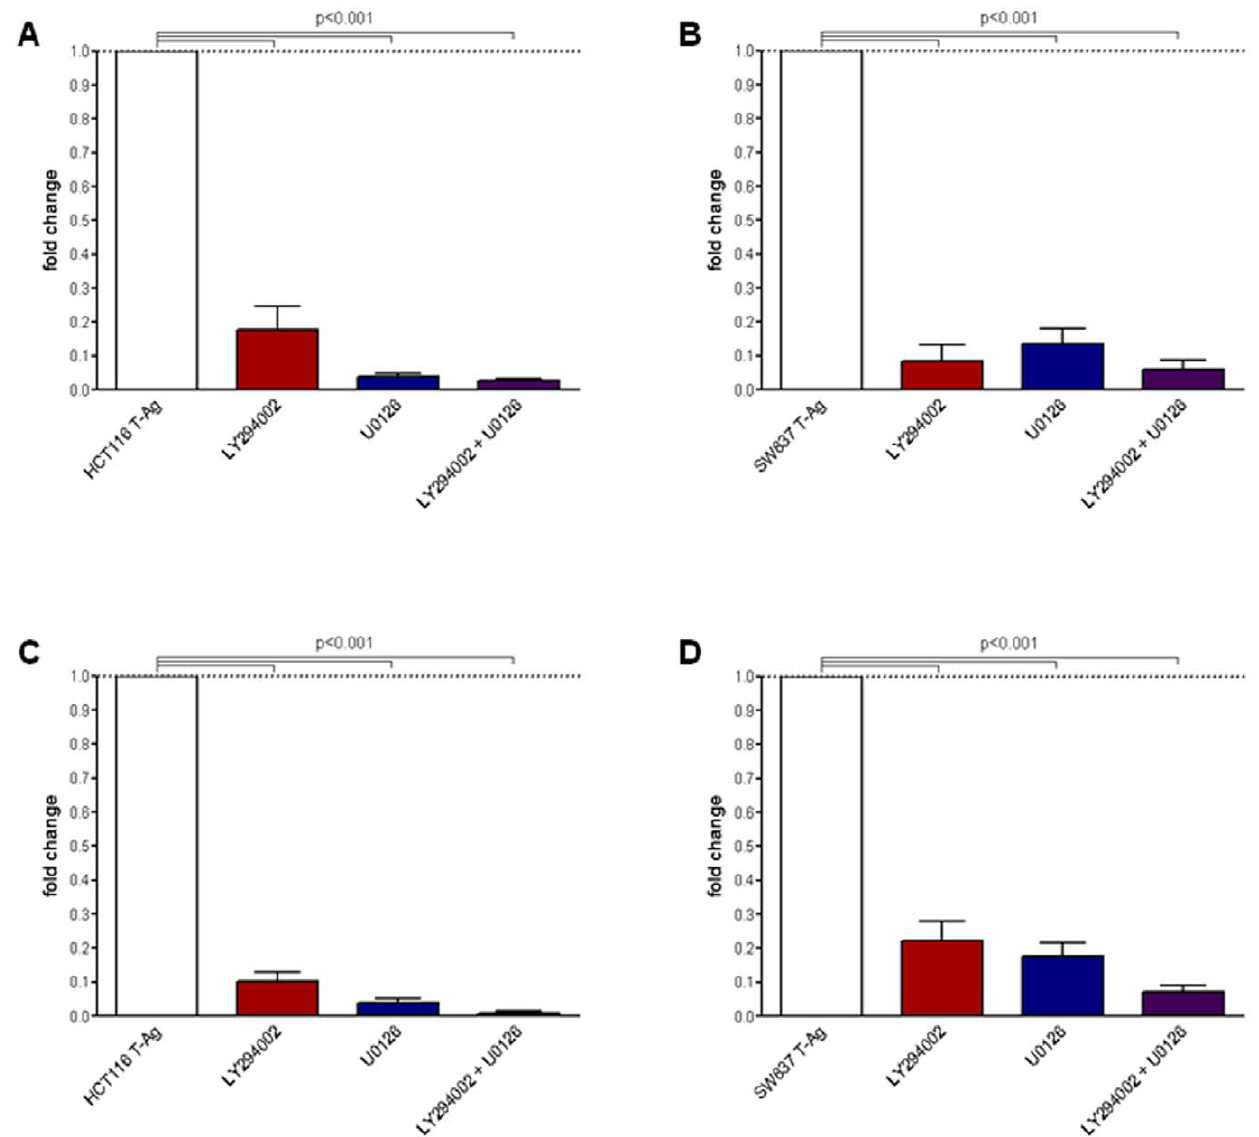
Figure 5. PI3K and MAPK pathway inhibitors reduced migration and invasion of JCV T-Ag transfected cells. Migration (panels A and B) and invasion (panels C and D) were performed using Boyden chambers without or with Matrigel. LY294002 (25 m M) and U0126 (10 m M) were added to both upper and lower chambers. Cells that invaded through Matrigel, and migrated through the 8 m m pores in the membrane were stained with DAPI. Cell counting was performed with ImageJ software. Data in bar graphs demonstrate fold changes normalized to vector cells (means 6 SE) obtained from 3 independent experiments. Significant inhibition in both migration and invasion was observed in both HCT116 and SW837 cells with LY294002 and U0126 individually and in